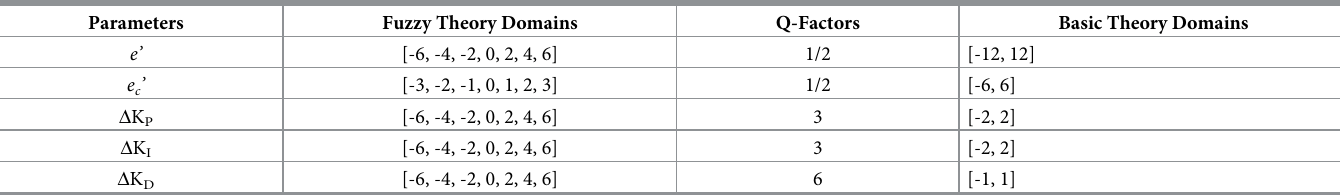
Table 3. Fuzzy theory and quantitative factors of unwinding